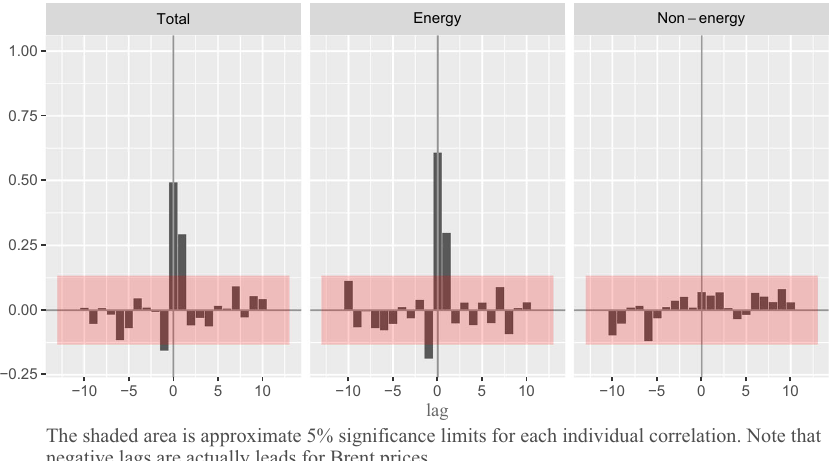
The shaded area is approximate 5% significance limits for each individual correlation. Note that negative lags are actually leads for Brent prices. Fig. 4 Cross-correlations between the prewhitened series of total ( P t ), energy ( E t ) and non-energy (NE t ) CPIs and Brent price ( O t ). Positive lags correspond to the response of P t , E t and NE t to shocks in O t , respectively, while negative lags correspond to the inverse causality relationship, Sample: 2002.01–2020.02